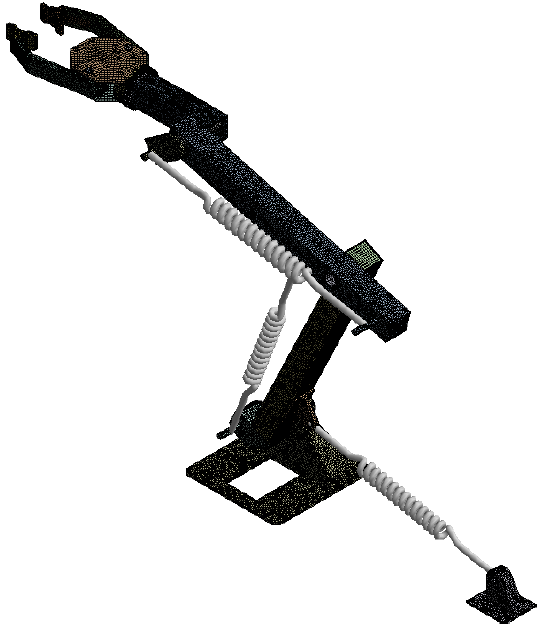
Figure 13. Representation of the finite element model in which the linear motors are replaced by elastic elements. elastic